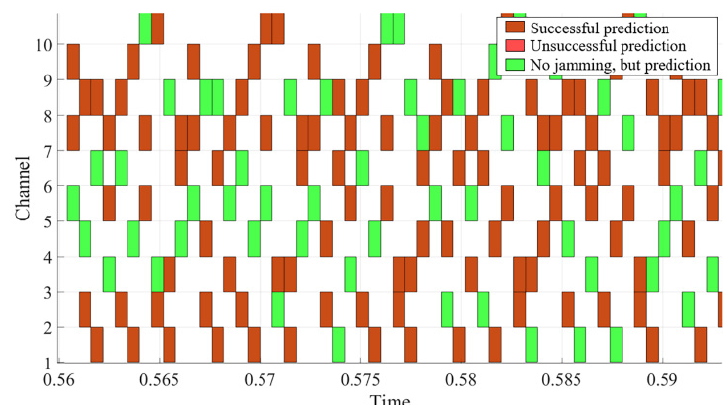
Figure 10. WBSS algorithm anti-intelligent blocking jamming channel decision diagram.